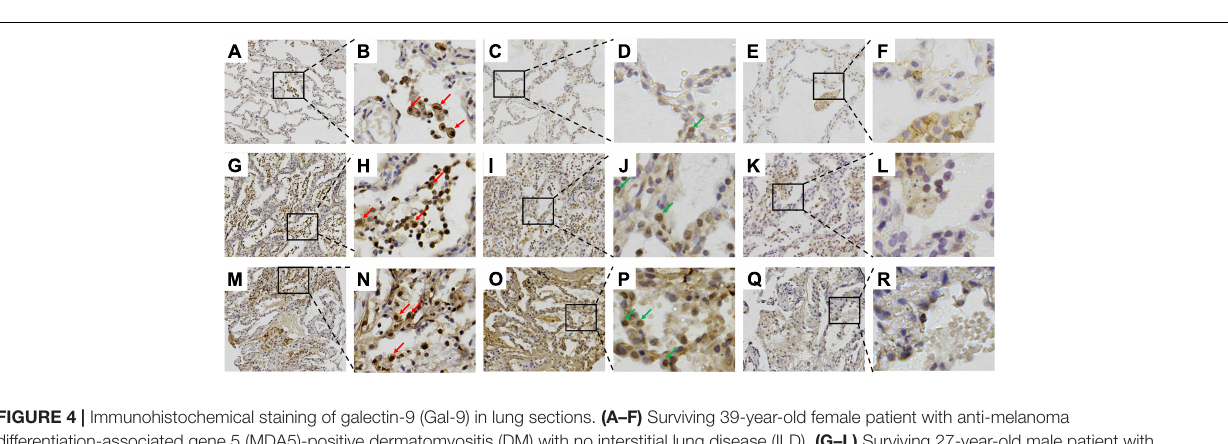
FIGURE 3 | Concentrations of galectin-9 (Gal-9) in peripheral blood mononuclear cells (PBMCs). PBMCs derived from patients with idiopathic inflammatory myopathies and healthy controls (HCs). (A) Gal-9 levels in PBMCs derived from patients with dermatomyositis (DM), patients with immune-mediated necrotizing myopathy (IMNM), and HCs. (B,C) mRNA expression of type-I interferon-inducible gene myxovirus resistance 1 (MX1) (B) and interferon induced with helicase C domain 1 (IFIH1) (C) in patients with DM, patients with IMNM, and HCs. (D,E) Correlations between Gal-9 and MX1 (D) and IFIH1 (E) mRNA expression levels in patients with DM. Horizontal bars indicate mean ± standard deviation.